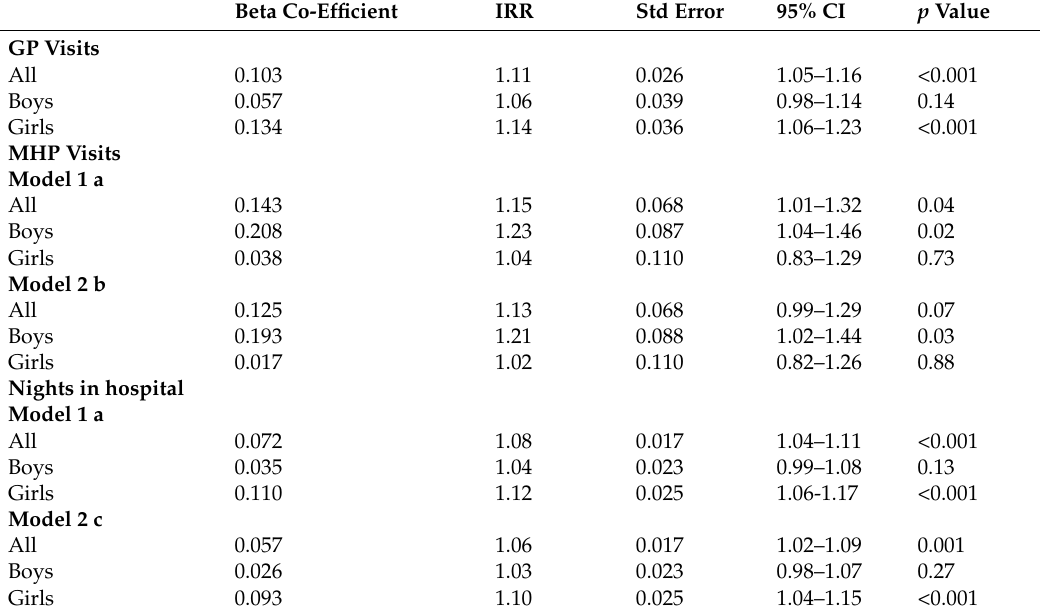
Table 4. Poisson Regression Models showing independent effect of victimisation on